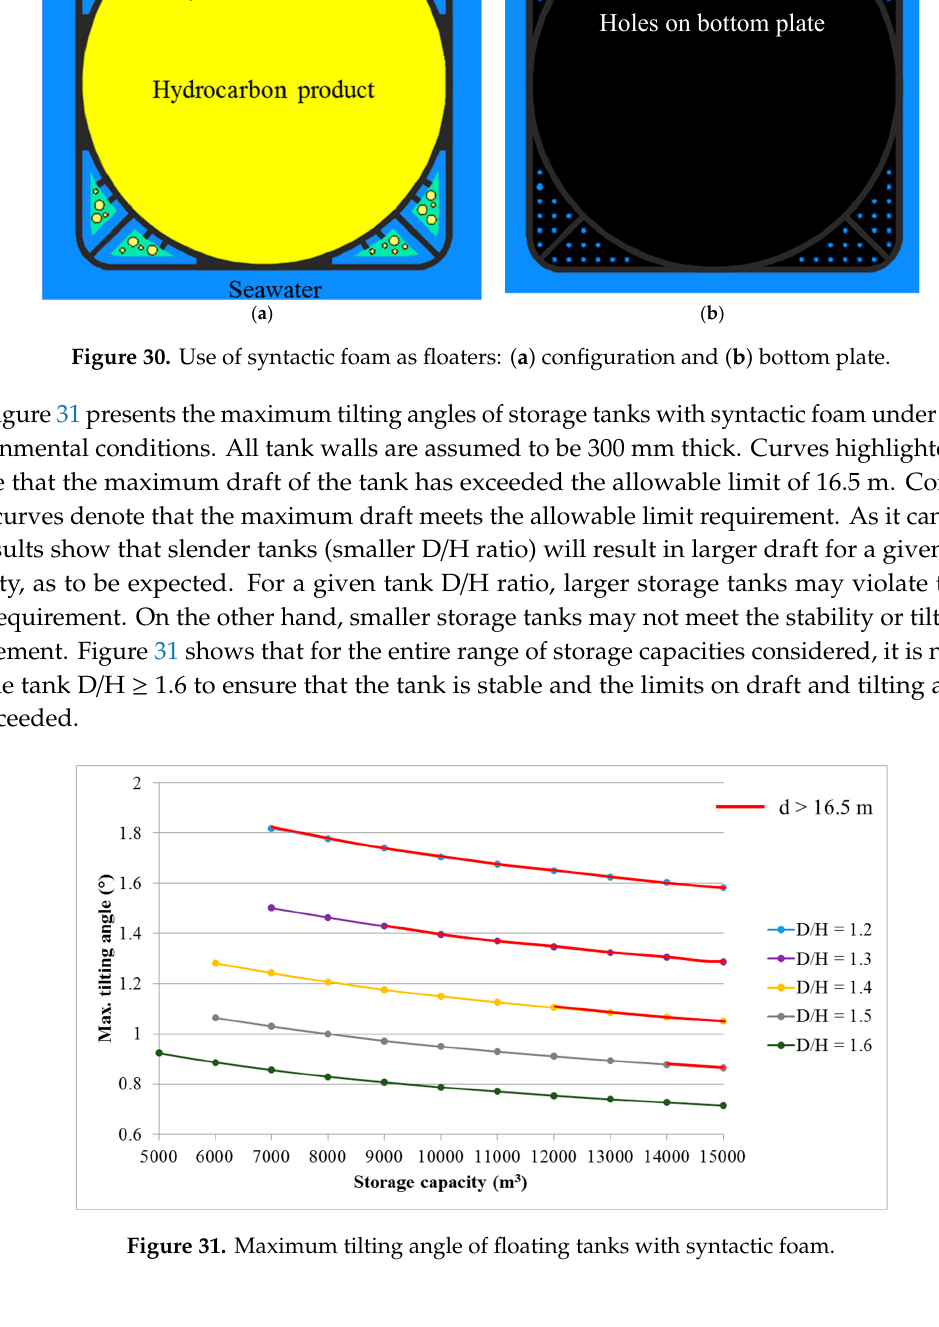
Figure 31. Maximum tilting angle of floating tanks with syntactic foam.